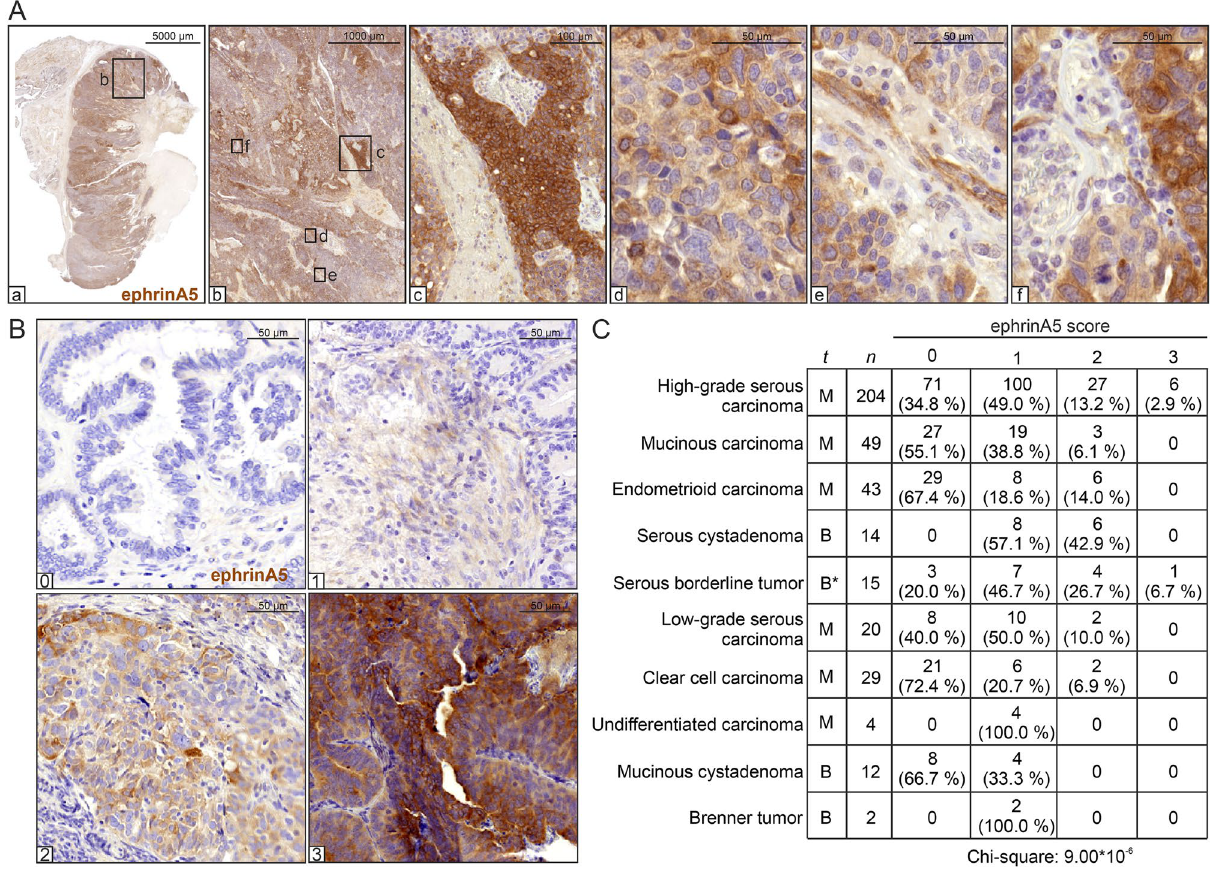
Figure 4. EphrinA5 protein expression is heterogeneous and associates with disease malignancy. ( A ) EphrinA5 IHC of a diagnosis-stage, treatment-naïve, primary HGSC tumor. Magnified images for different tumor areas. ( B ) Representative images of ephrinA5 IHC used for scoring the ovarian tumor TMAs. ( C ) Correlation of ephrinA5 protein expression with different epithelial OC subtypes and benign tumors ordered according to the weighted arithmetic mean of ephrinA5 score (descending order). t = tissue type, M = malignant, B = benign, * = mostly benign. Pearson chi ‐ square test showed highest overall ephrinA5 expression in HGSC (p = 9.00 × 10 −6